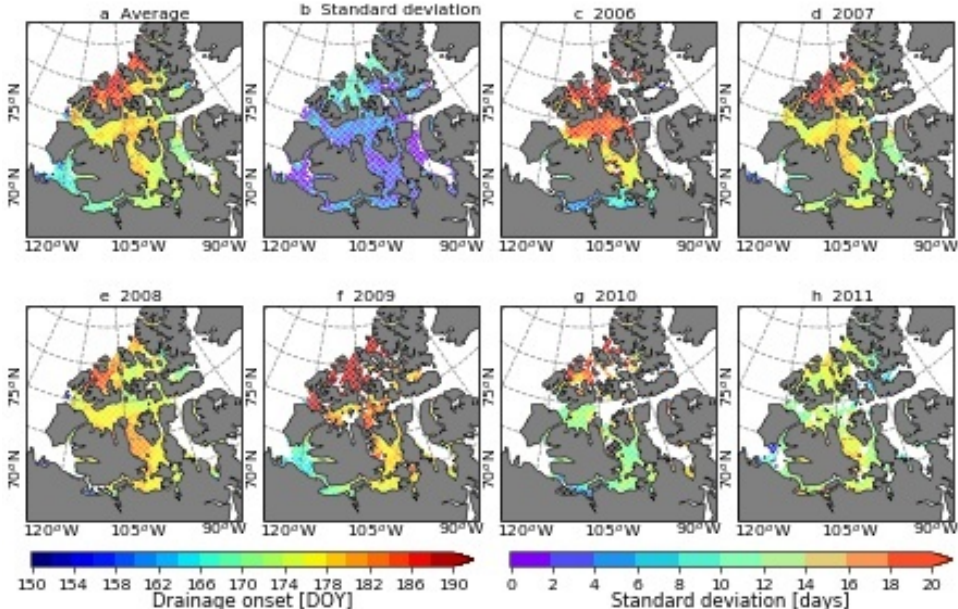
Figure 8. Spatial distributions of drainage onset (DO) in the Canadian Arctic Archipelago, from 2006 to 2011. Black points are Case 2.